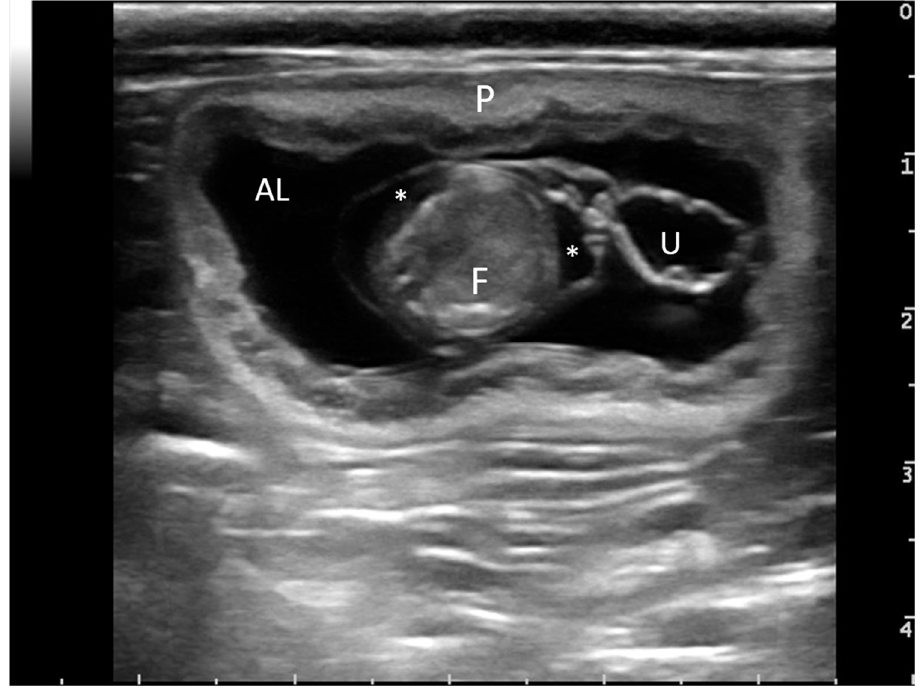
Figure 1. Ultrasonographic examination of an embryo vesicle. Placenta is marked with “P”, allantoic sac with “AL”, amniotic sac with “*”, fetus with “F” and umbilical cord with “U”. Group D 20 included 7 AMN samples and 0 ALL; group D 25 included 7 AMN and 7 ALL samples; group D 30 was composed of 7 AMN and 7 ALL samples; group D 40 included 7 AMN and 7 ALL; group D 45 included 8 AMN and 8 ALL; and D 60 included 8 AMN and 8 ALL